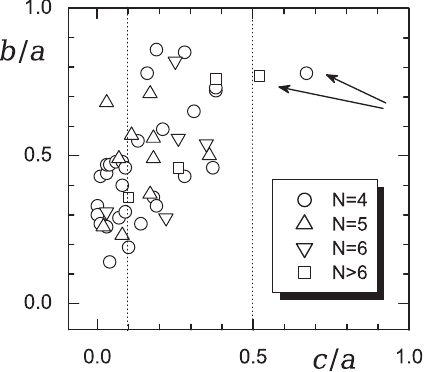
Fig. 2. Positions on the c=a (cid:0) b=a plane for 49 superclusters with a multiplicity ranging from 4 to 9. Vertical lines corre- spond to c=a values of 0.1 and 0.5. Ar- rows denote superclusters with c=a > 0 : 5, b=a > 0 :